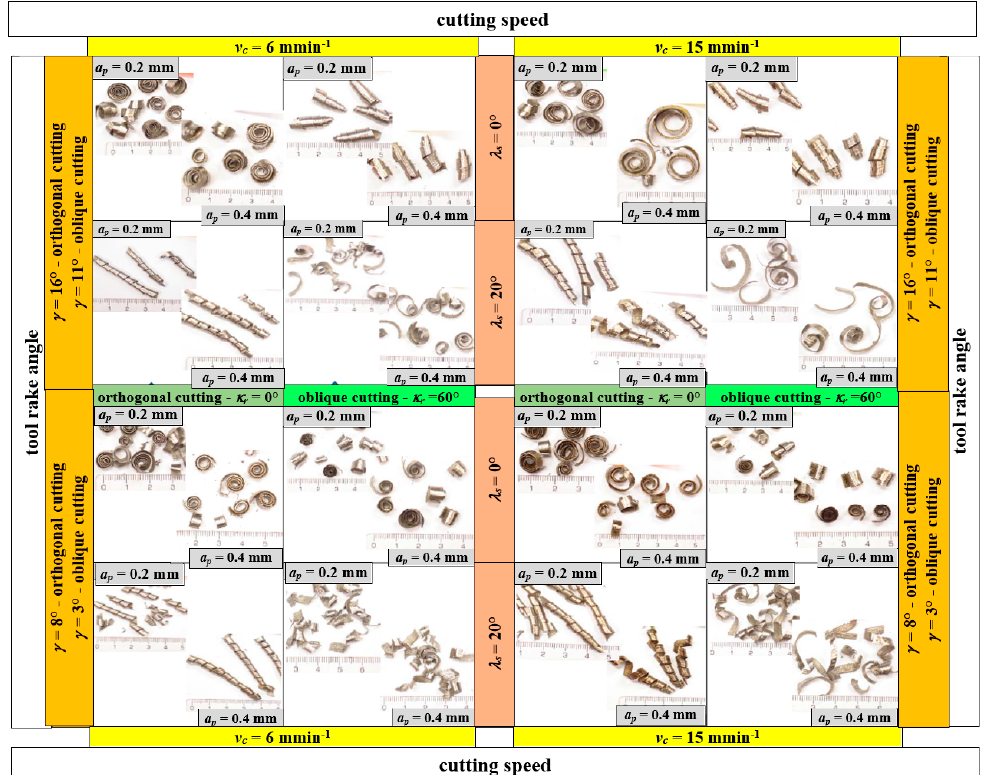
Figure 26. The shapes of chips of EN C45 steel and their dependence on cutting parameters. Metals 2019 , 9 , x FOR PEER REVIEW